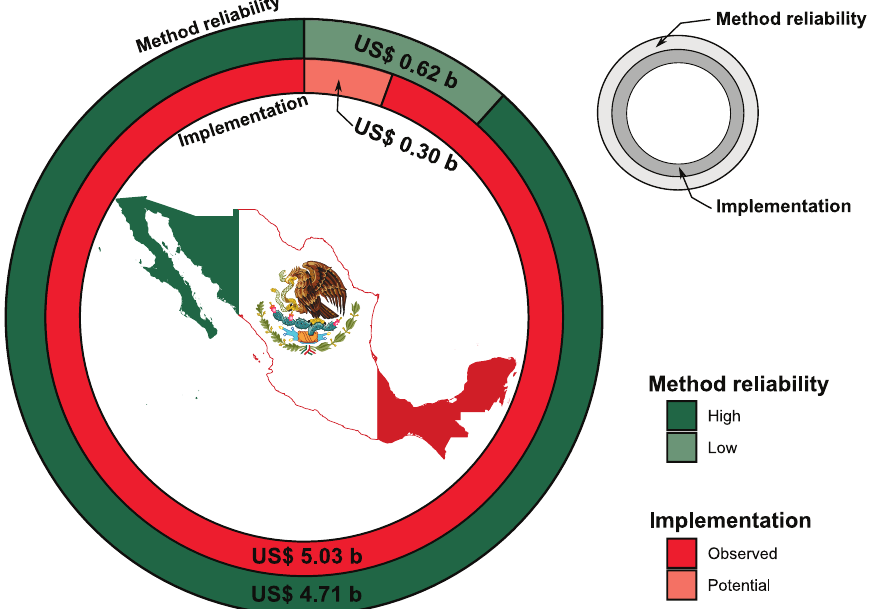
Figure 1. Total economic cost for invasive species in Mexico according to the level of reliability of the cost estimates and whether the costs were empirically observed or not (implementation). Costs are re- ported in US $, billion (i.e., 10 9